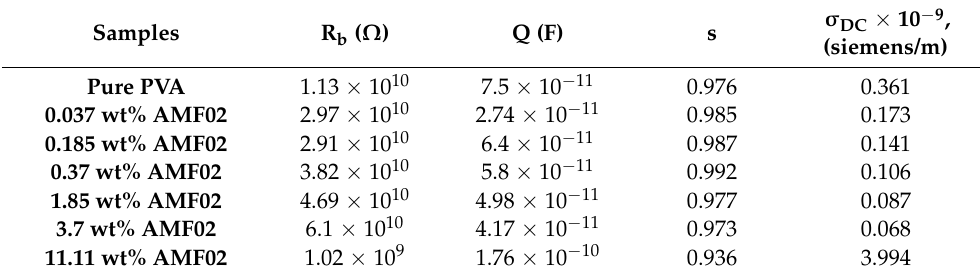
Table 4. Dielectric fitting various novel